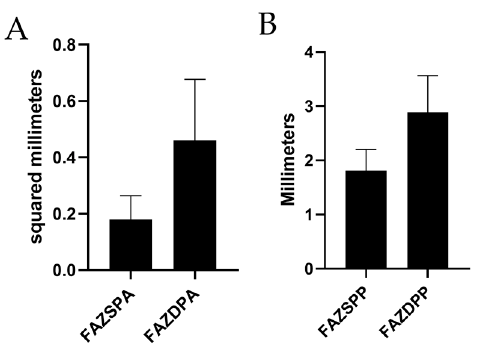
Figure 15. The mean area ( A ) and perimeter ( B ) for superficial and deep plexuses in the FAZ. FAZSPA = foveal avascular zone and superficial plexus area; FAZSPP = foveal avascular zone and superficial plexus perimeter; FAZDPA = foveal avascular zone and deep plexus area; FAZDPP = foveal avascular zone and deep plexus perimeter.